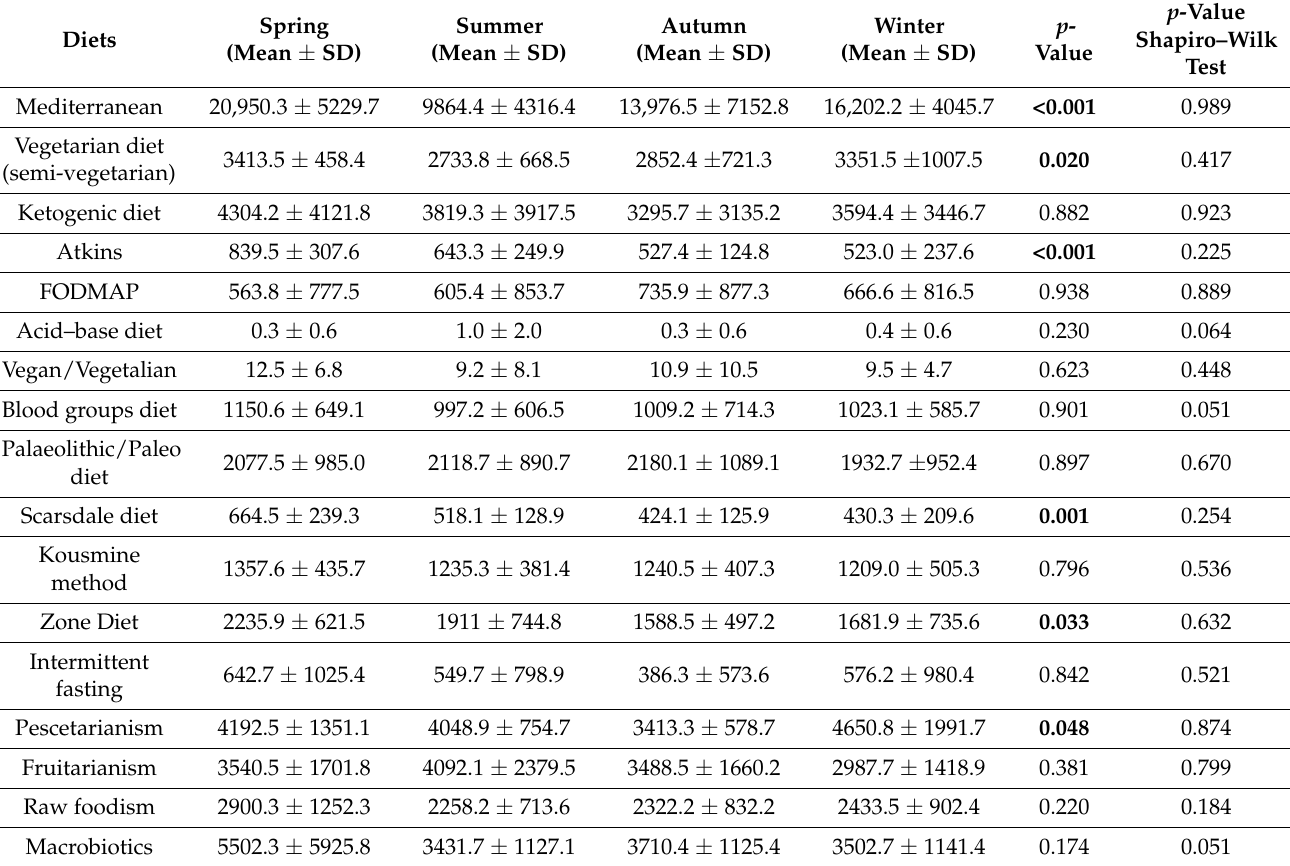
Table 1. Seasonal distribution and differences in the number of times a specific page was viewed by users.